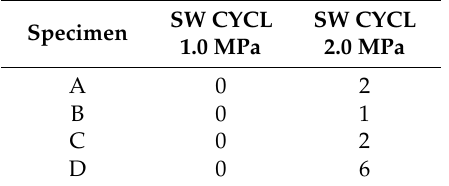
Table 9. Number of cracks formed during cyclic preloading of the sandwich beams.